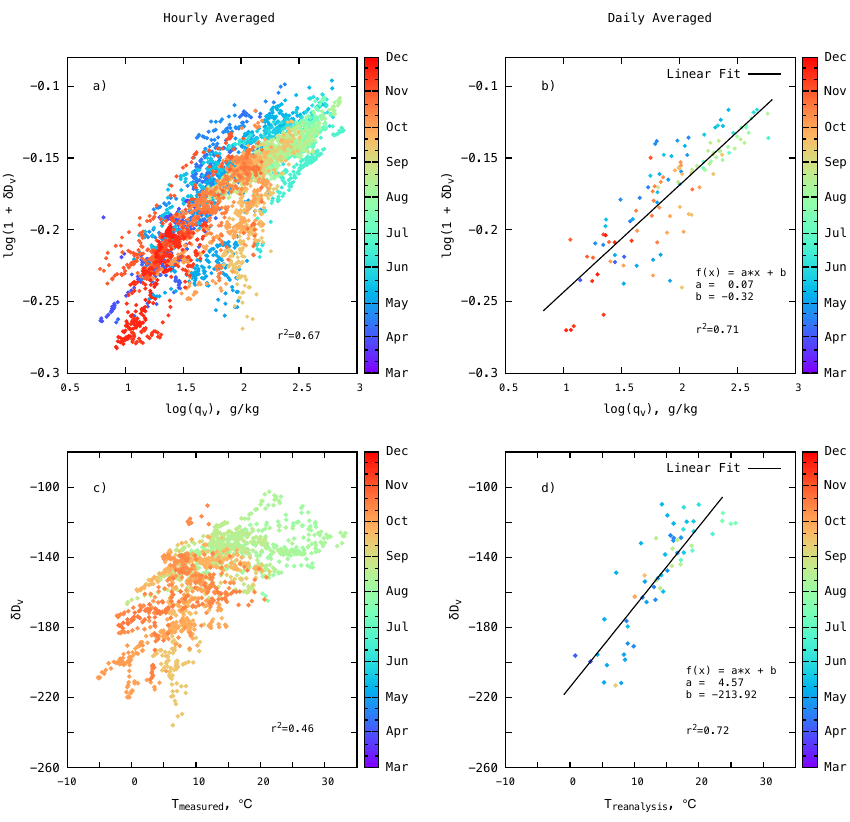
Figure 4. Scatter plots for ln ( 1 + δ D v ) vs. ln (q v ) , hourly (a) and daily (b) means; δ D v (PICARRO) vs. local temperature measured at Kourovka (c) ; δ D v (PICARRO) vs. ERA-Interim reanalysis temperatures (d)